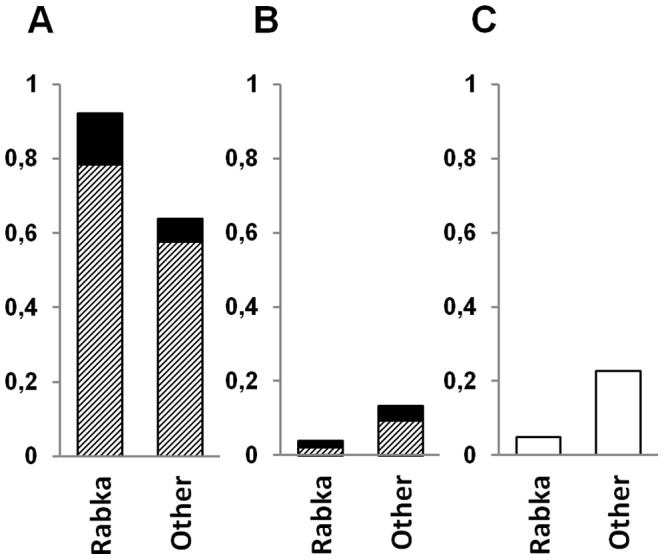

CFTR mutation detection efficiency in PL CF patients from different health centers.A. Both mutations identified. B. One mutation identified. C. No mutation identified. Diagonal stripes – INNOLiPA mutations; solid black – non-INNOLiPA mutations. Rabka – Institute of Tuberculosis and Lung Diseases in Rabka; Other – other health care centers in Poland.